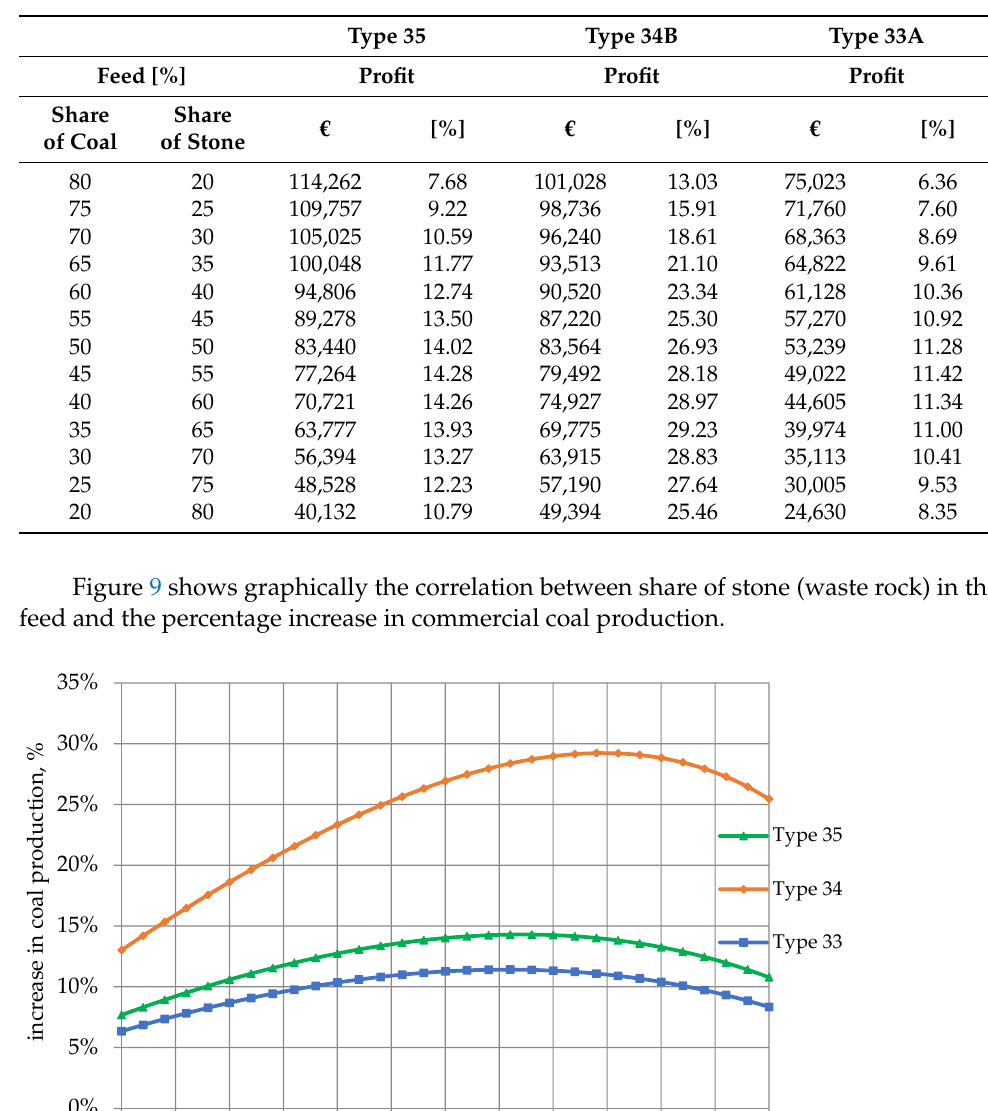
Table 7. Hourly profit from the selective crushing process—capacity 1000 t/h.